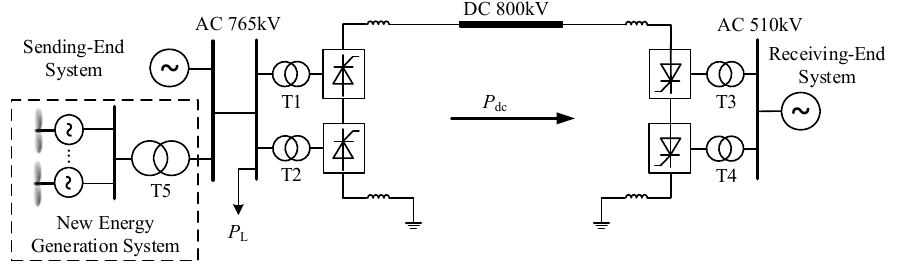
Figure 10. Principle structure of experiment system.